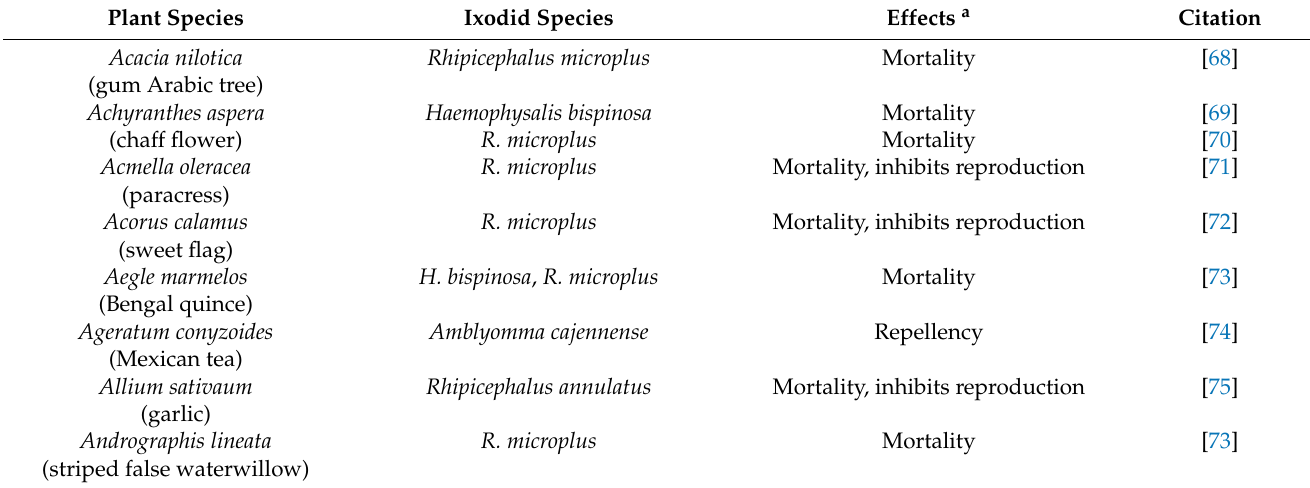
Table 1. Selected studies that report lethal and sublethal effects of botanical extracts (solvents, exposure times, experimental conditions, and other parameters are not